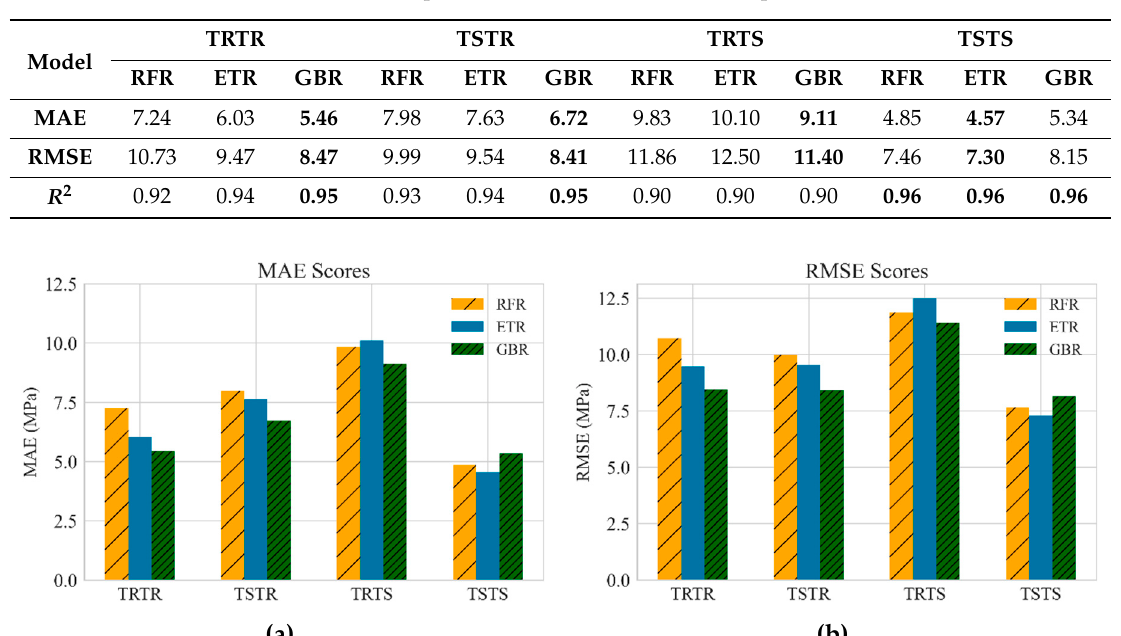
Figure 2. Comparison of performance of developed models ( a ) MAE score, and ( b ) RMSE score.